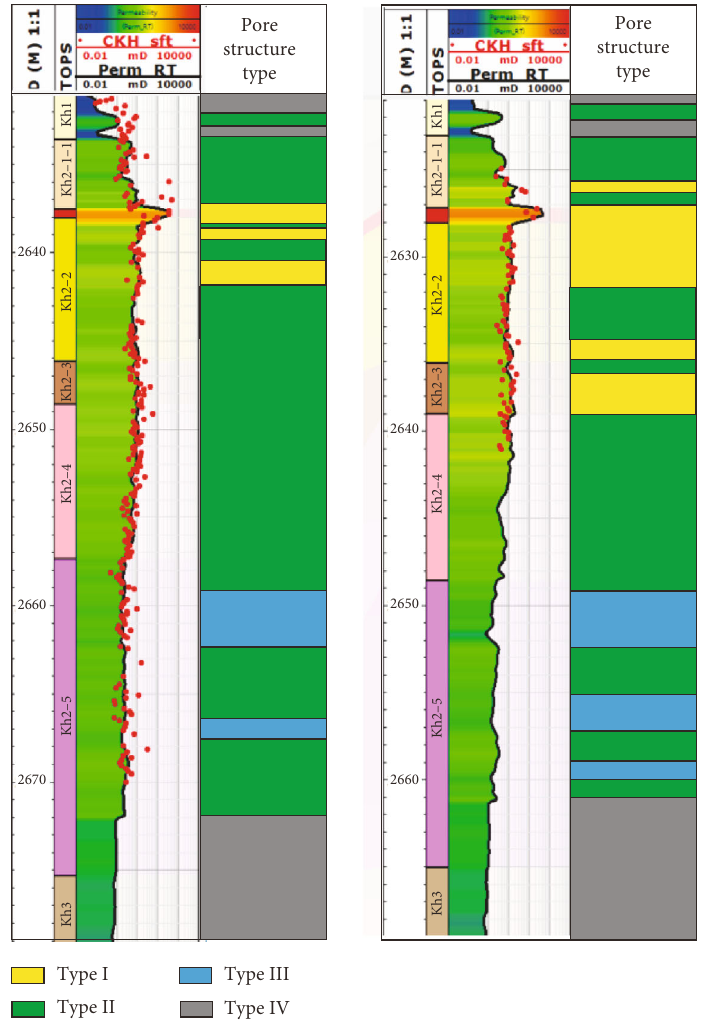
Figure 14: The results of permeability prediction for two